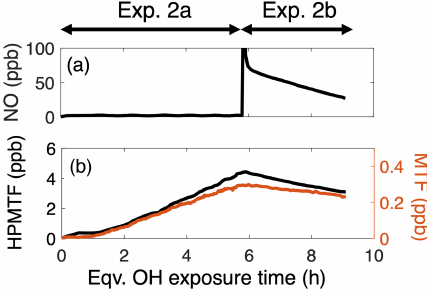
Figure 4. (a) NO concentration measured by the NO–NO 2 –NO x analyzer in Exp. 2. At OH exposure ∼ 5 . 8h, 70ppb of NO was in- jected into the chamber. (b) Time series of HPMTF- 12 C 2 and MTF- 12 C 2 in Exp. 2. The decay of HPMTF and MTF was used to esti- mate their reaction rate coefficients with